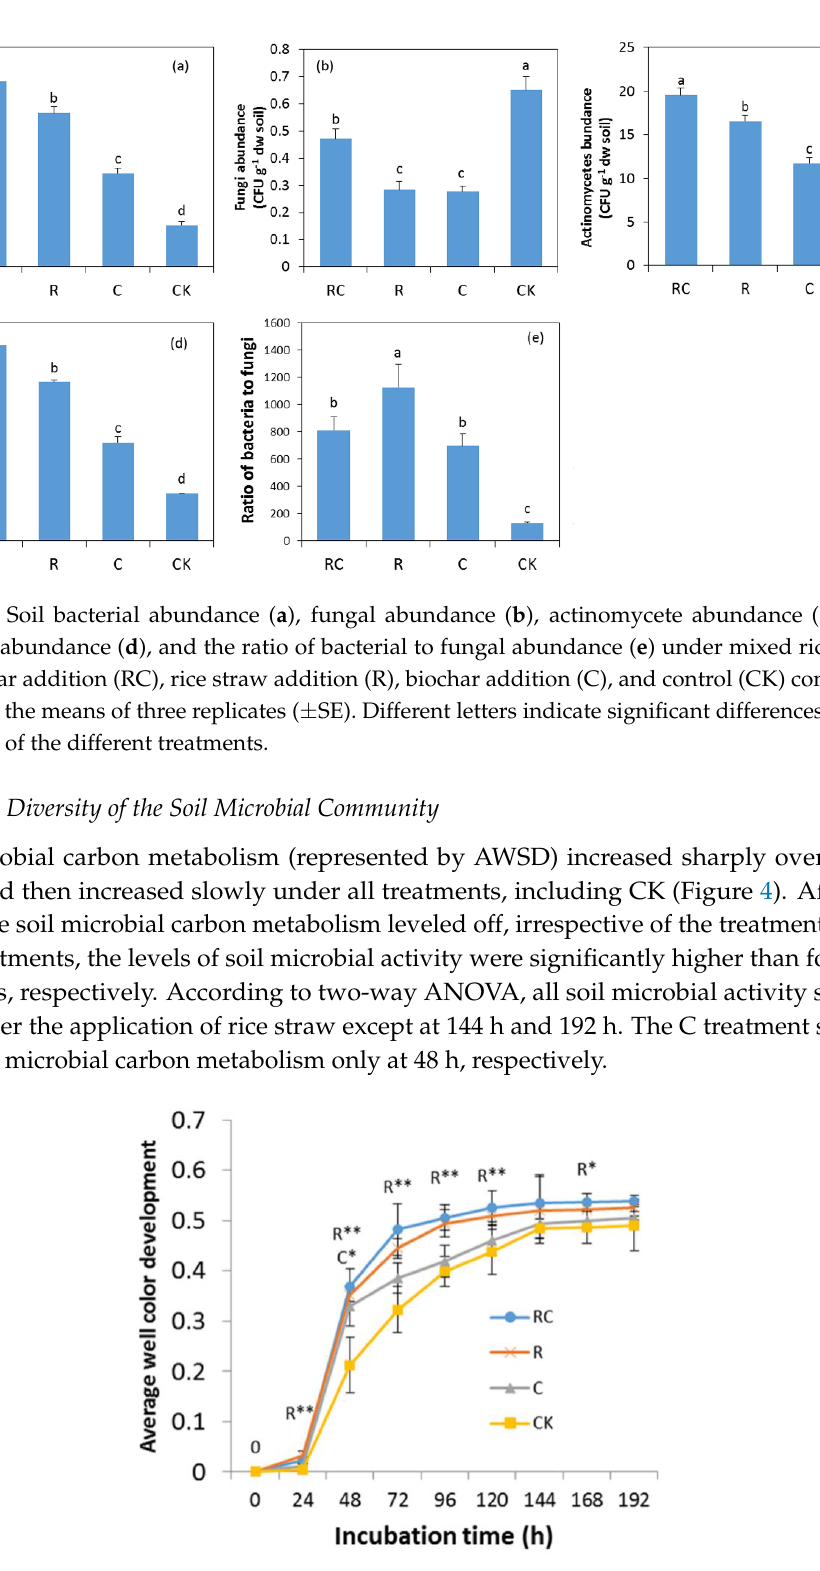
Figure 4. Changes in soil microbial community average well color development (AWCD) with incubation time under mixed rice straw and biochar addition (RC), rice straw addition (R), biochar addition (C), and control (CK) conditions. Values are the means of three replicates (±SE). R and C in the panel indicate significant rice straw and biochar effects, respectively. *, ** represent significance at p < 0.05 and p < 0.01 levels, respectively.